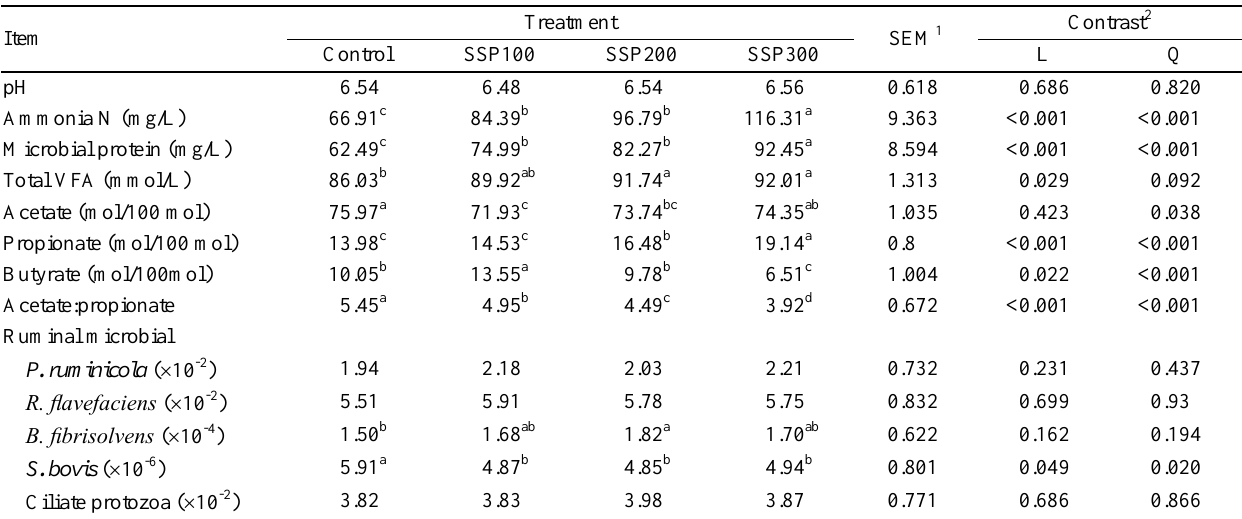
Table 4. Effects of soybean small peptide (SSP) infusion into rumen at the rates of 0 (Control), 100 (SSP100), 200 (SSP200) and 300 (SSP300) g/d on characteristics of rumen fermentation and microbial abundance as determined by marker gene copy number in total bacterial 16 S rRNA (percentage of total bacterial 16 S rRNA ) (n =